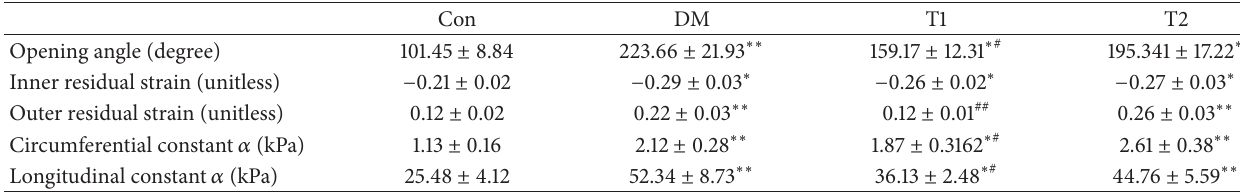
Table 2: Parameters of biomechanical properties of colon.